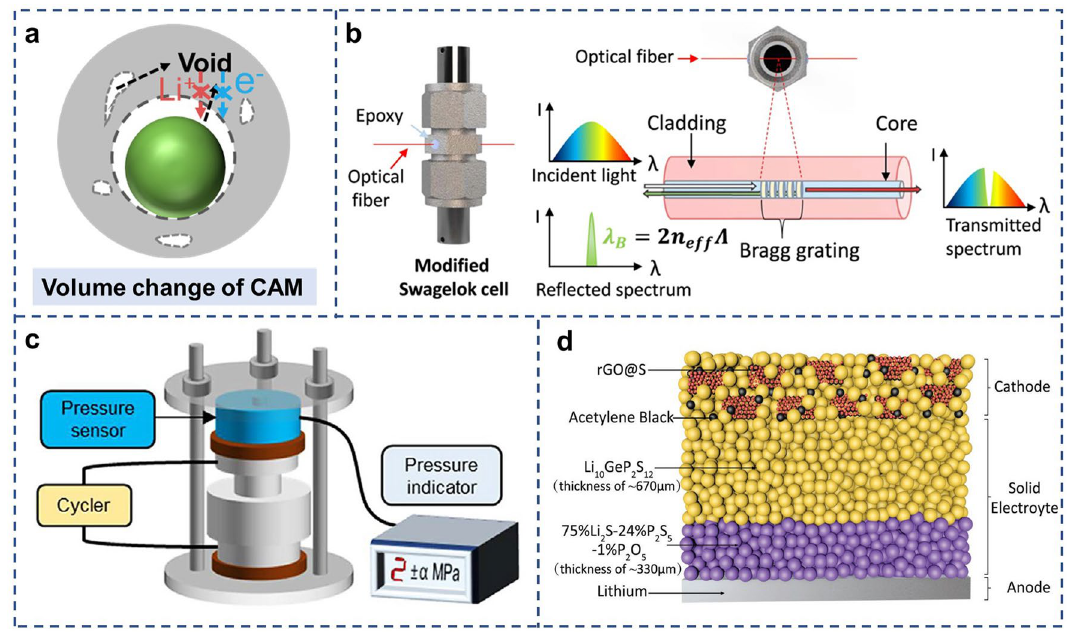
Fig. 3 a Schematic diagram of volume change in the composite sulfur cathode. b Scheme of the integration of an FBG into an in-house modi- fied Swagelok cell together with the working principle of an FBG optical sensor. Copyright from Ref. [52]. c Schematic diagram of pressure monitoring all-solid-state cells. Copyright from Ref. [53]. d Schematic diagram of all-solid-state lithium–sulfur battery using rGo@S composite